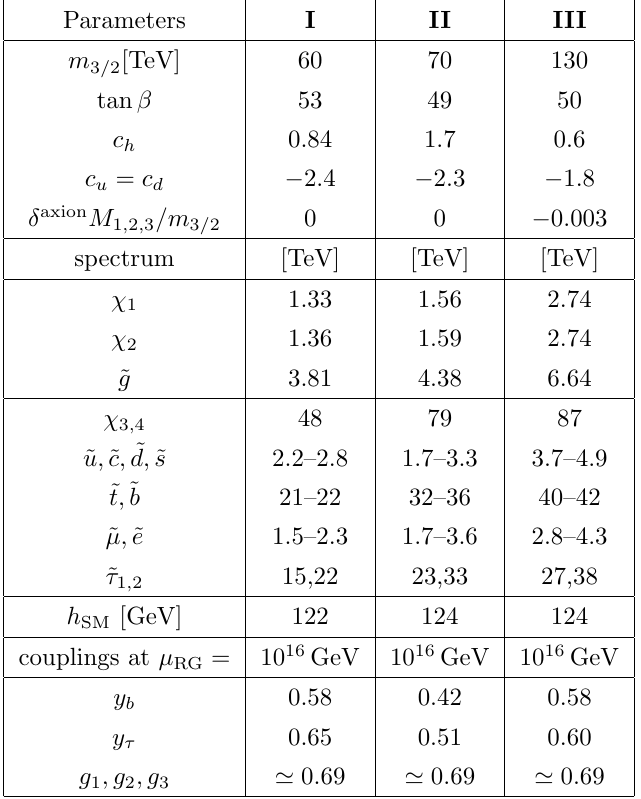
h 2 (cid:24) 0 : 1 according to ref. 1